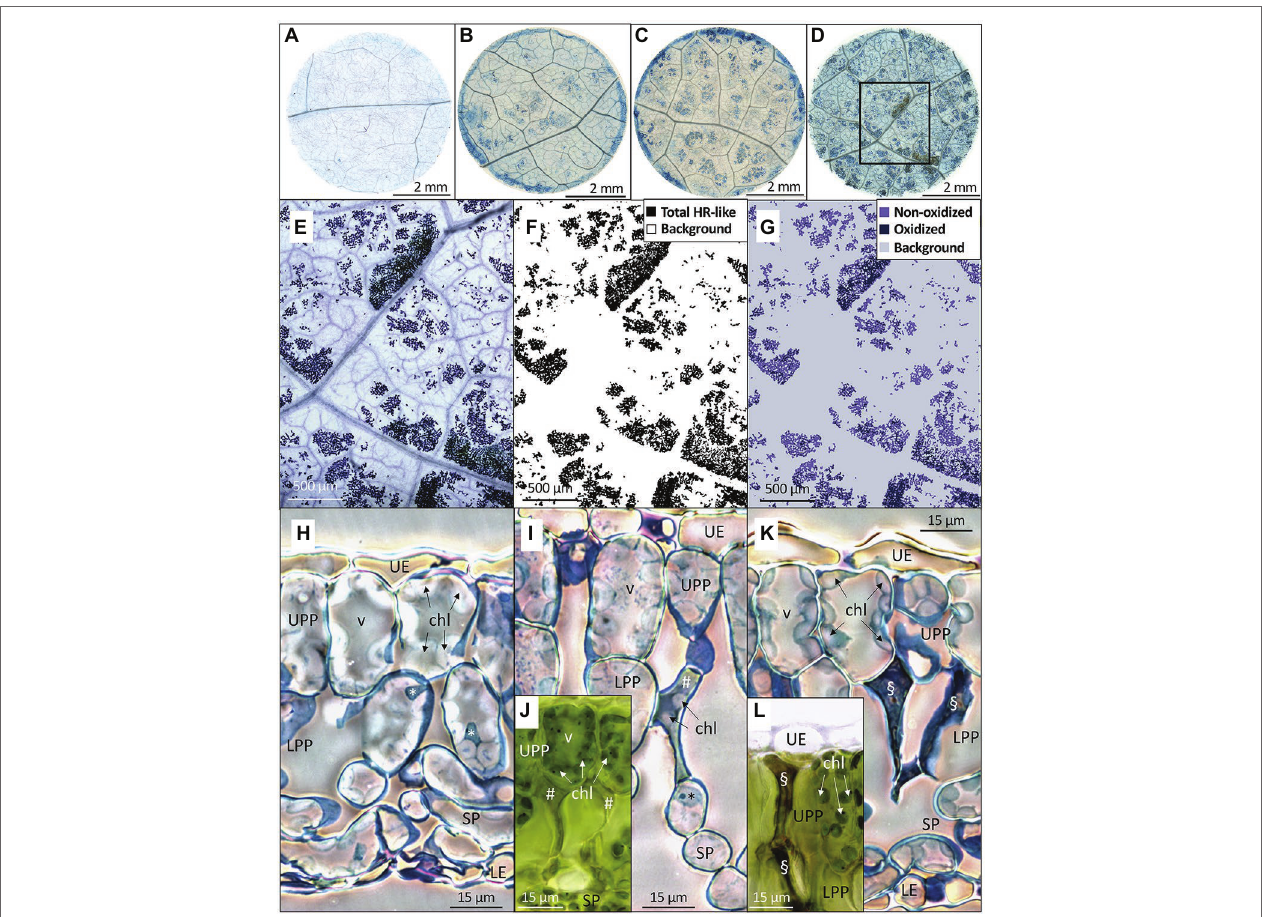
FIGURE 4 | Distribution, morphology, and structural properties of HR-like lesions within hybrid poplar leaves ( Populus tremula x alba ). (A–D) Foliar discs excised at low leaf position (third) from leaves exposed to 100 ppb O 3 during 2 (A) , 8 (B) , 13 (C) , and 27 (D) days. (A) Central area within each disk was photographed each time (frame in D ). (E–G) Image analysis of HR-like lesion after 27 days of treatment, as framed in (D) . (E) Synthetic digital image, made of 9 stitched micrographs (5x magnification). The lesions are separated by veinlets and non-symptomatic tissues. (F) The binary image of total HR-like lesion vs. background (white). (G) Classification of HR-like injuries into oxidized and non-oxidized lesion groups, based on color classes. (H–L) Changes in the mesophyll tissue and cell structure underlying the HR-like lesions. (H) Asymptomatic leaf tissues in a leaf sample from the filtered air treatment. I–L: necrotic cells within the upper (UPP) and lower (LPP) palisade parenchyma underlying the HR-like lesions. (I,J) Within mesophyll cells having recently undergone HR-like necrosis (#), the chloroplasts (chl) were still visible and had retained their green color (J) . (K,L) at a later stage, the HR-like lesions (§) showed cell-content disruption and oxidation (L) . Other structures: UE, upper epidermis; SP, spongy parenchyma; LE, lower epidermis; v, vacuole; *, nucleus. Technical specifications: staining with Trypan blue (A–E) and Toluidine blue (H,I,K) ; observations in bright field microscopy (A–E,H–L) using phase-contrast (H,I,K) ; (J,L) fresh, unfixed and unstained leaf sample